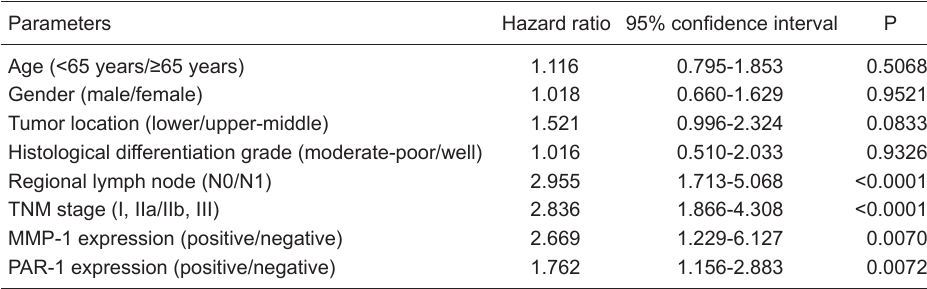
Table 2. Univariate analysis of disease-free survival by Cox’s proportional hazard model. Parameters